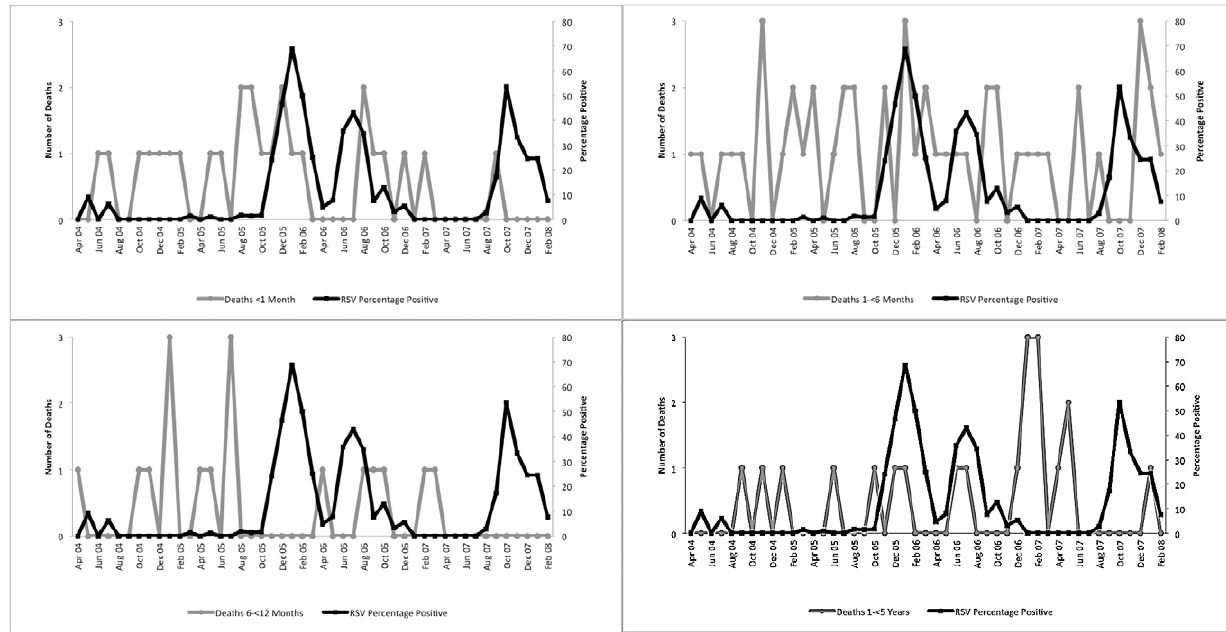
Figure 4. Deaths from acute lower respiratory illness, Matlab, and RSV detections, Dhaka, among children under 5 years, by age group, April 2004–February 2008.